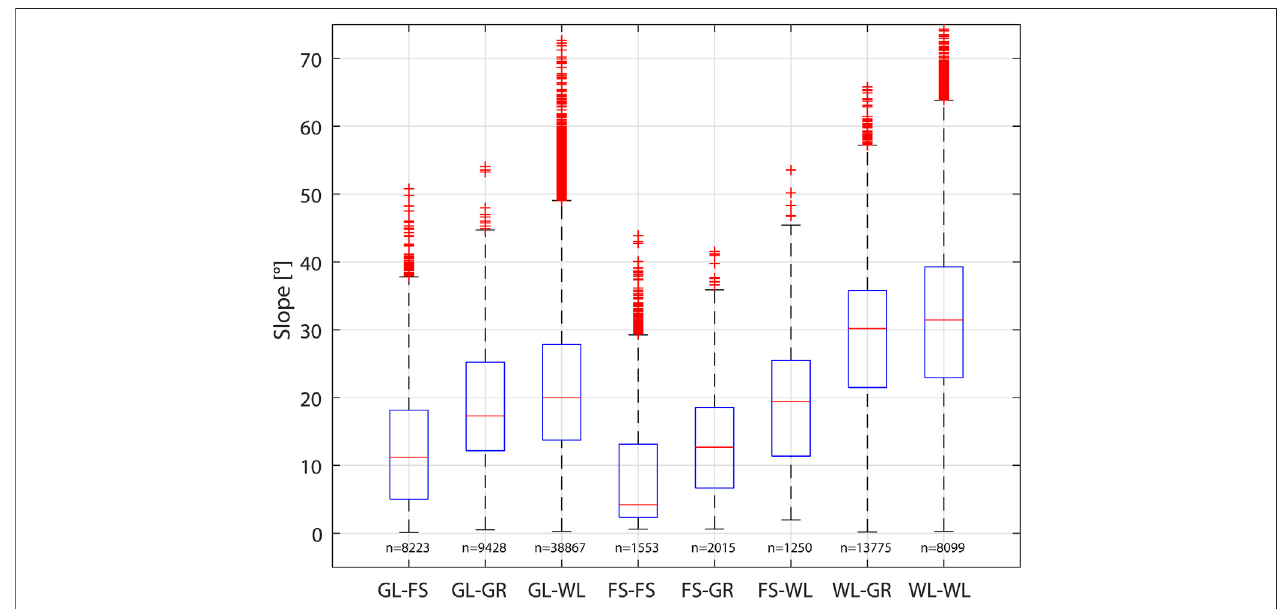
FIGURE 7 | Terrain slope versus land cover transformation of the fl uvial corridors 1870 – 2015 in the proglacial area that deglaciated between 1864 and 2015 (for abbreviations see Table 3 ; compare Figure 1 ; n (cid:1) number of 5 m raster cells).